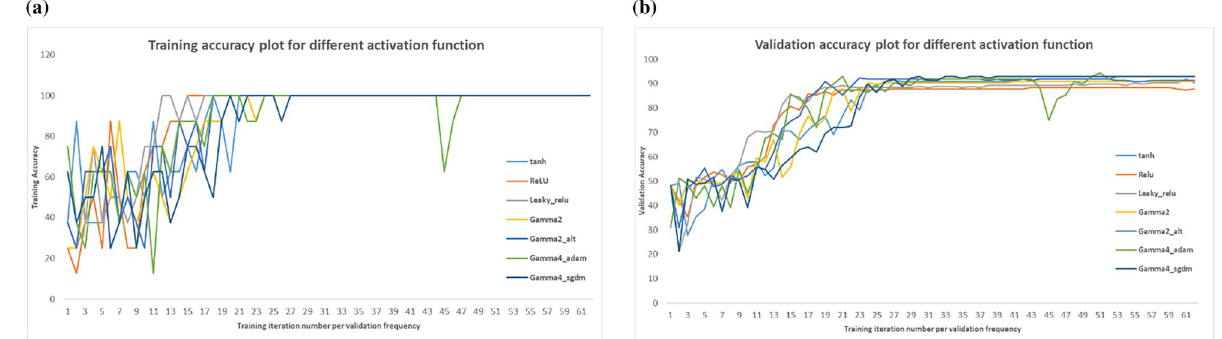
Figure 6. ( a ) Training accuracy plot for MRI classification using baseline CNN models with different activation functions. ( b ) Validation accuracy plot for MRI classification using baseline CNN models with different activation functions.